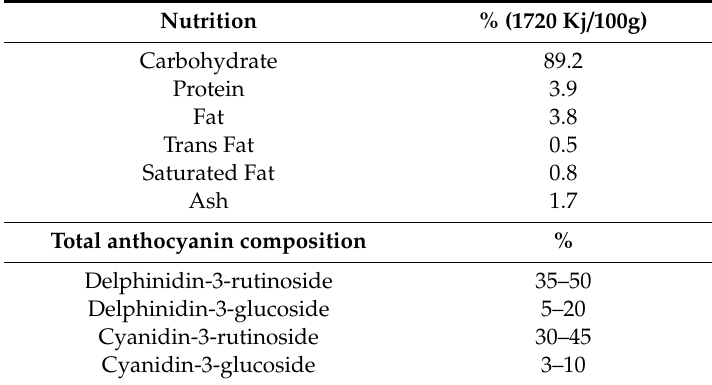
Table 1. Nutrition facts and total anthocyanin contents of blackcurrant ( Ribes nigrum L) extracts a